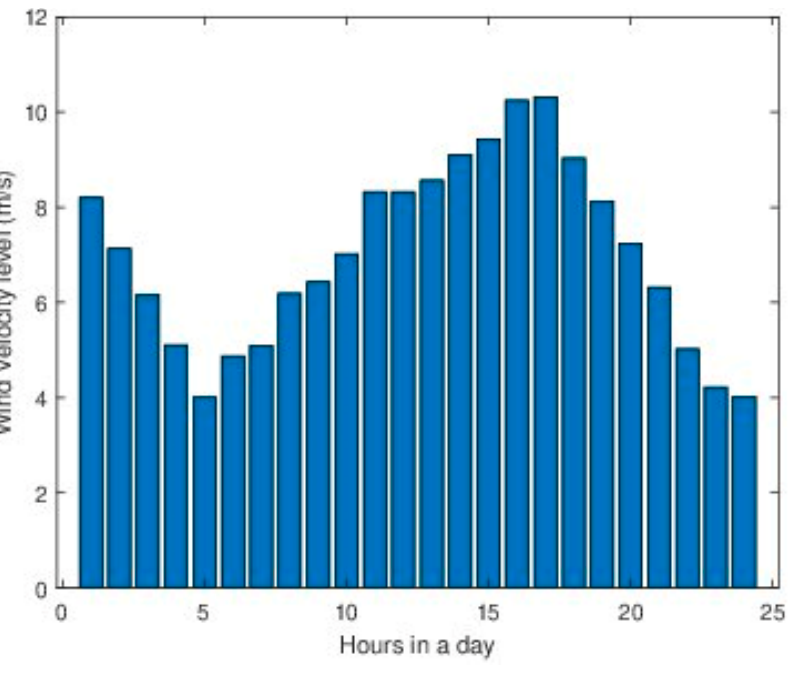
Table 5. Various parameters and their values.